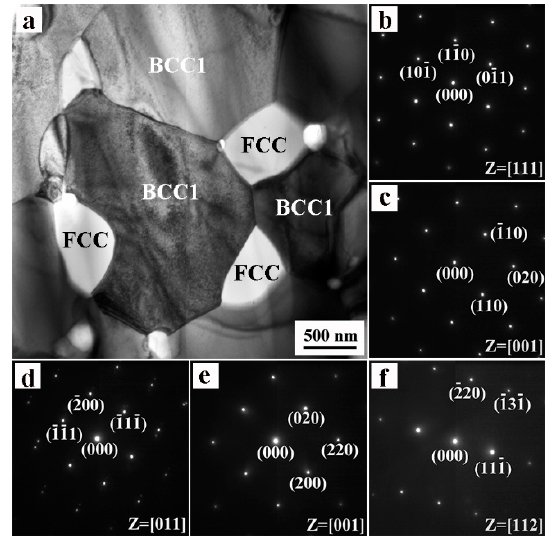
Figure 3. TEM images of the bulk NbMoTaWVTi HEA: ( a ) Bright-field image; ( b , c ) SAED patterns of BCC1 phase along [111] and [001] zone axis, respectively; ( d – f ) SAED patterns of FCC phase along [011], [001] and [112] zone axis, respectively.